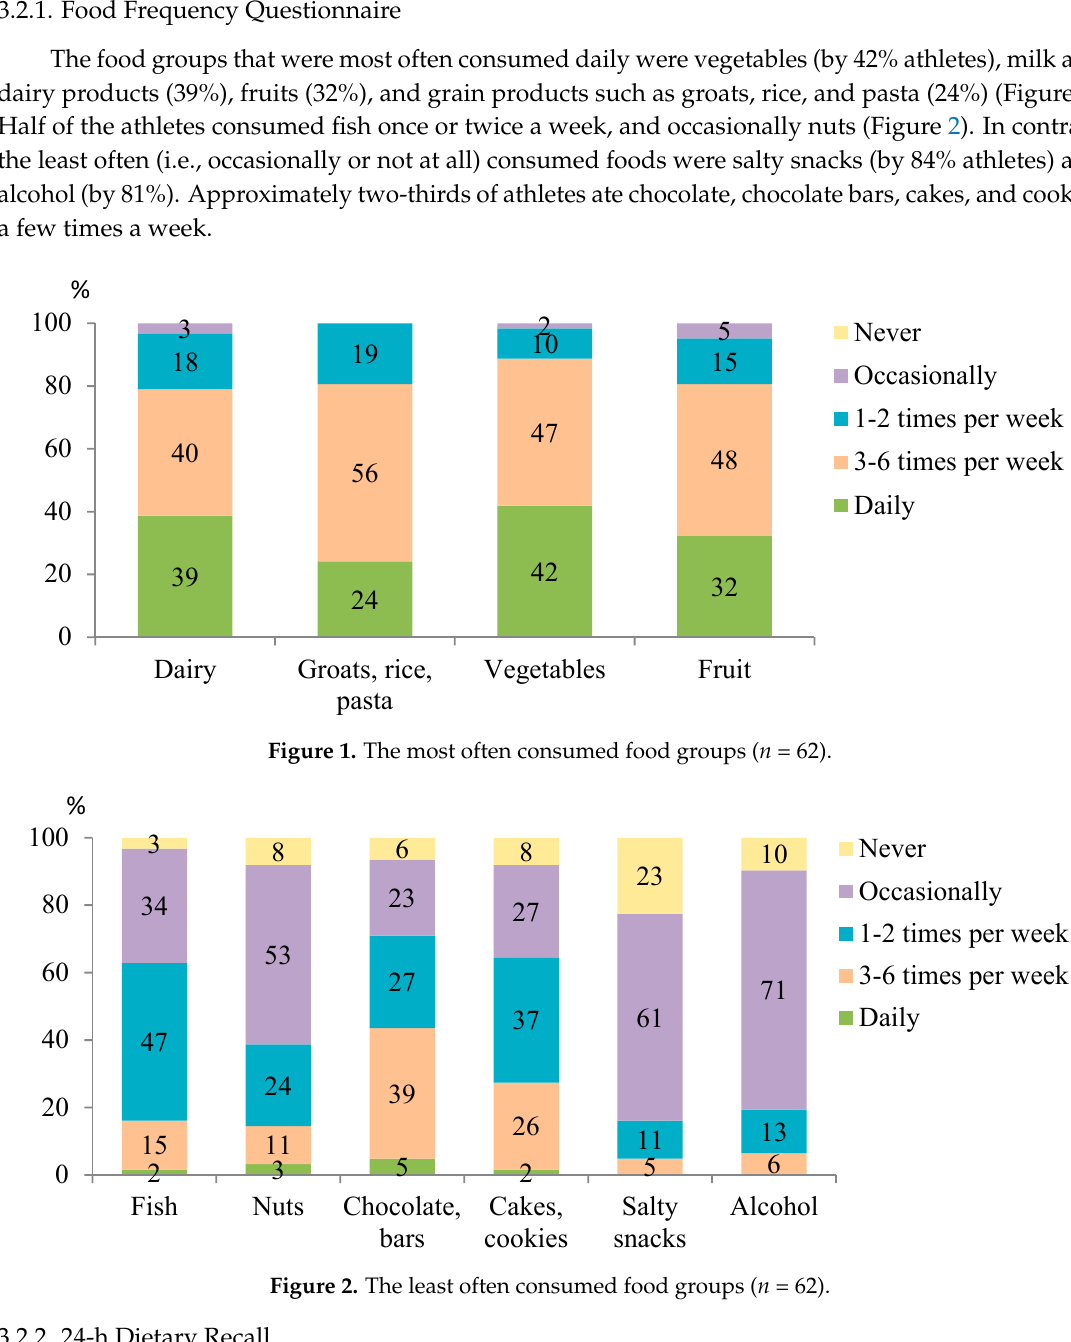
Figure 2. The least often consumed food groups ( n = 62).